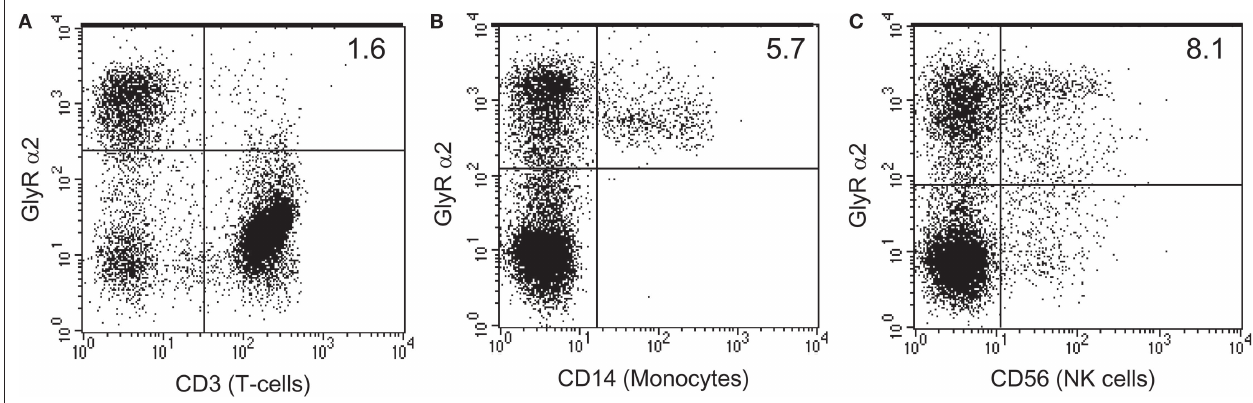
the PBMC population and was mostly negative for GlyR α 2 expression (A) , whilst all of the monocyte population (CD14 + ) was positive for GlyR α 2 (B) . More than half of the natural killer (NK) population (CD56 + ) was positive for GlyR α 2 (C) . However, since the T cell population was negative, it is likely that the NK T cells are also negative. Cells that were positive for both GlyR α 2 and for the lineage specifi c cell surface marker appear in the top right hand side